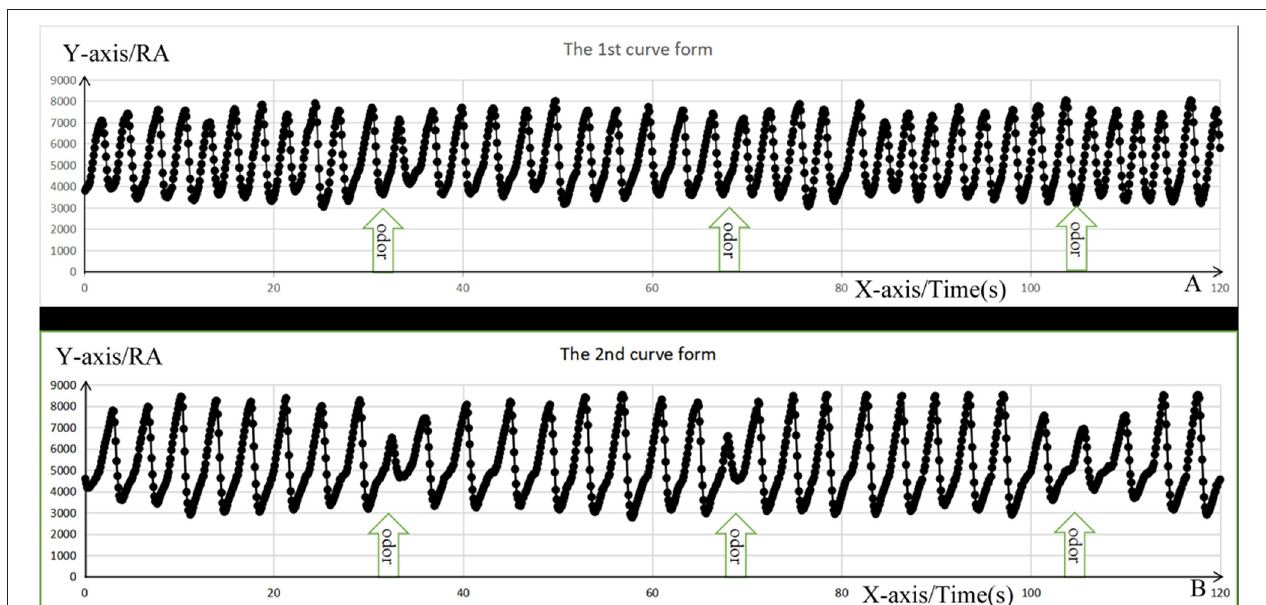
FIGURE 4 | The change form of respiratory amplitude curve. The X -axis represents respiratory time; the Y -axis represents respiratory amplitude (RA) value, and the black dots represent the values of RA per ms. (A) Represents the first respiratory form with no significant respiratory change, whereas (B) represents the second respiratory form with short ventilation during inspiration, followed by decrease in the breathing amplitude, shortening the inhalation time, and gradually getting their breath back.